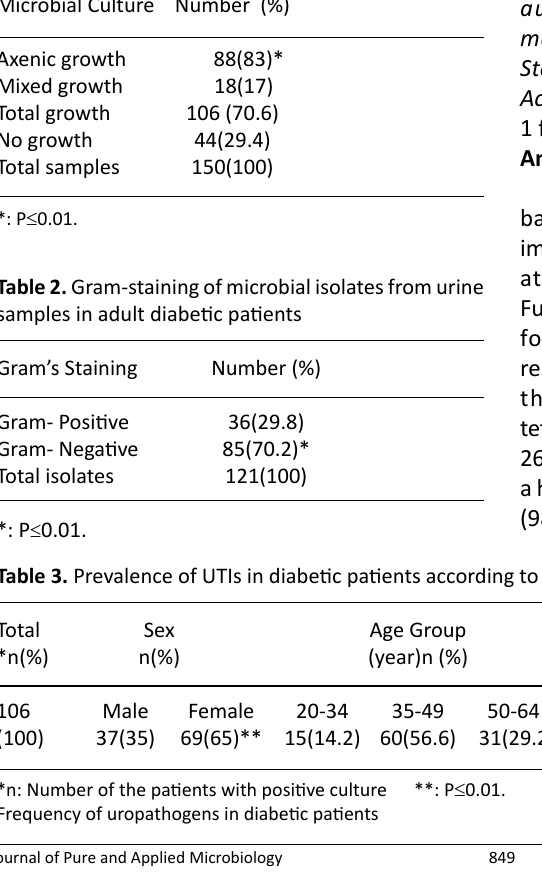
Table 1. Growth of uropathogens isolated from urine samples in adult diabetic Patients Microbial Culture Number (%)